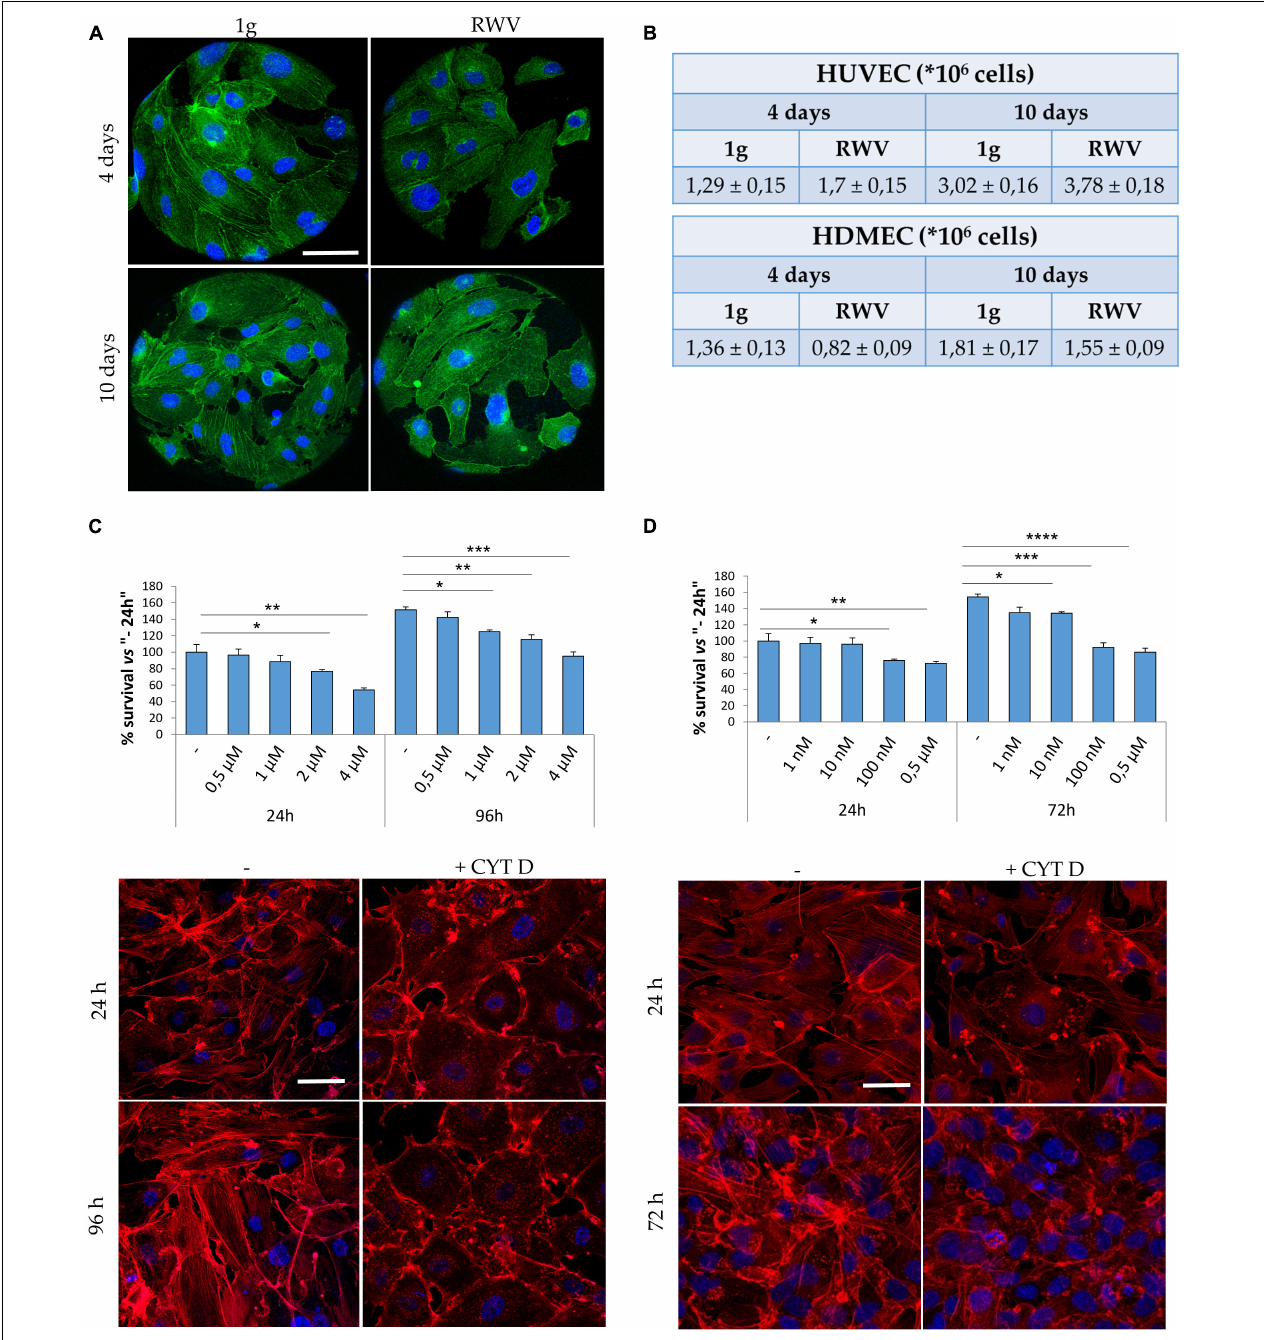
FIGURE 1 | Cytoskeletal remodeling in cells cultured in simulated microgravity or exposed to CYT D. (A) Staining for actin (green) and nuclei (blue) in human dermal microvascular endothelial cell (HDMEC) grown on microcarrier beads in 1g or in the Rotating Wall Vessels (RWV) for 4 and 10 days. Scale bar: 40 µ m. (B) Table showing the counts of human endothelial cell from umbilical vein (HUVEC) (upper table) and HDMEC (lower table) cultured in the RWV. (C,D) Different doses of CYT D were tested on HUVEC (C) and HDMEC (D) . MTT (upper panel) was performed after 24–96 or 24–72 h for HUVEC and HDMEC, respectively. Staining for actin (red) was performed at 24–96 h (HUVEC) or 24–72 h (HDMEC) in the presence of the selected dose (lower panels). Nuclear staining in blue. Scale bar: 40 µ m. * P < 0.05, ** P < 0.01, *** P < 0.001, and **** p < 0.0001.